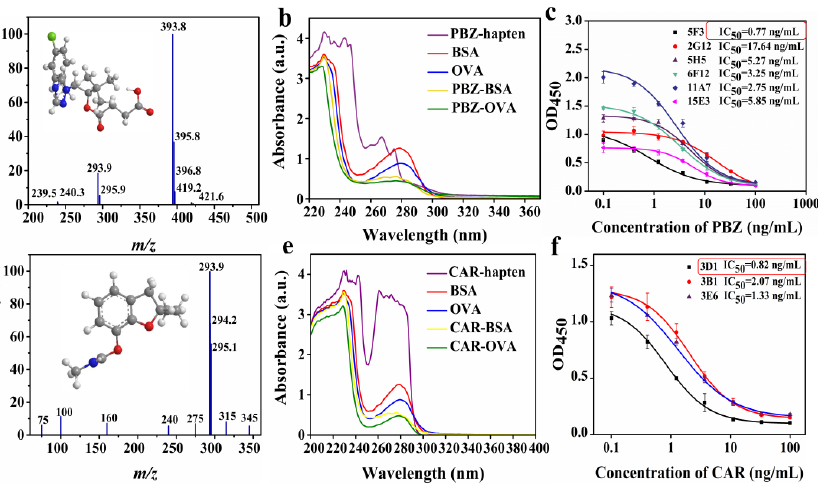
Figure 1. Characterization of antigens and antibodies. ( a ) Mass spectrometry of PBZ hapten. ( b ) UV – vis absorption spectra of PBZ hapten, PBZ – BSA, and PBZ – OVA. ( c ) IC 50 results of PBZ mAb. ( d